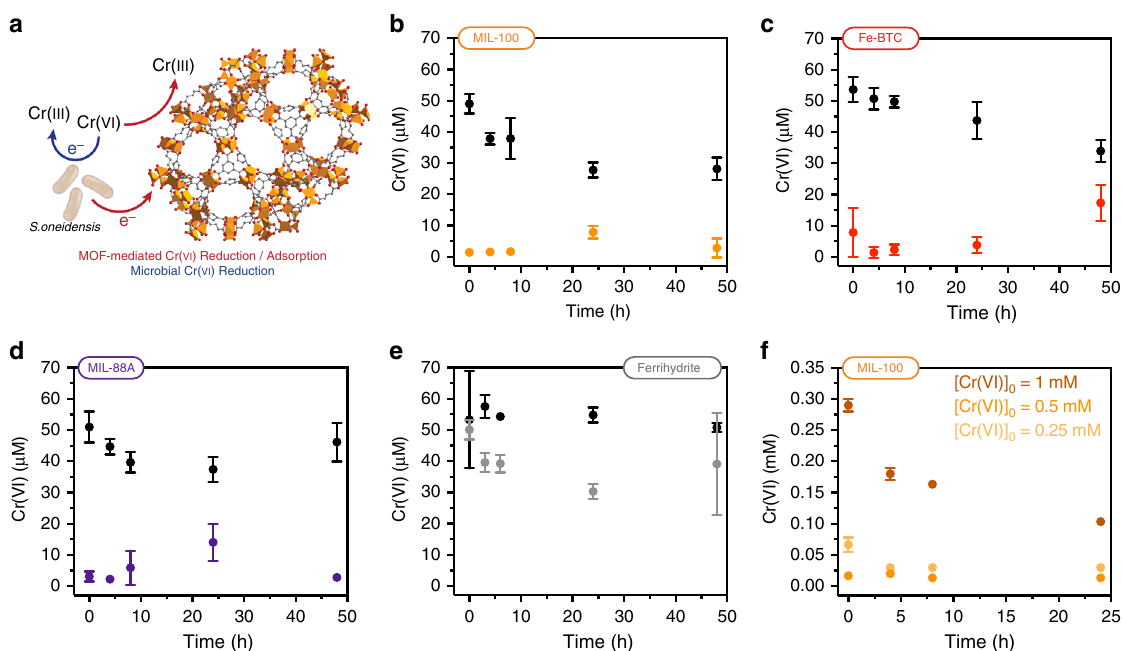
Fig. 5 Cr(VI) removal in reduced metal-organic frameworks. a Generalized scheme for Cr(VI) reduction by both S. oneidensis MR-1 and a reduced metal- organic framework. b – e Cr(VI) removal by S. oneidensis MR-1-reduced b MIL-100, c Fe-BTC, d MIL-88A, and e ferrihydrite when challenged with 70 µ M Cr (VI). Abiotic samples for each material are shown in black. f Cr(VI) removal by S. oneidensis MR-1-reduced MIL-100 when challenged with 0.25 mM, 0.5 mM, and 1 mM Cr(VI). All data shown are mean ± S.D. for three independent replicates. Source data for b – f are provided as a Source Data fi